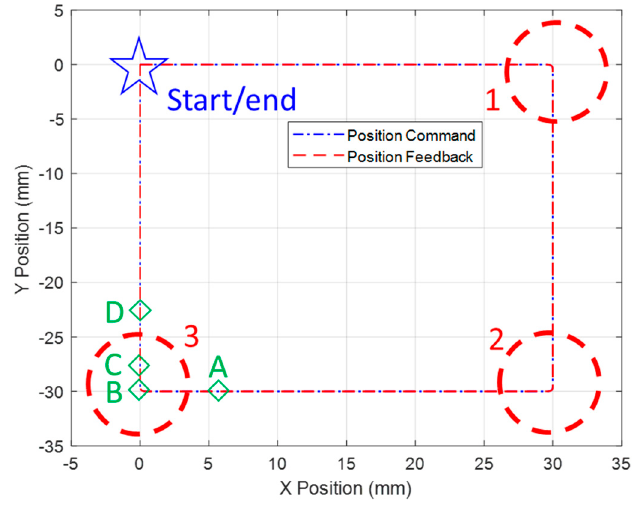
Figure 7. Testing trajectory. (The corner 1, 2 and 3 were described in Section 3.2.1 and the period A, B, C and D were described in Section 3.2.2.).